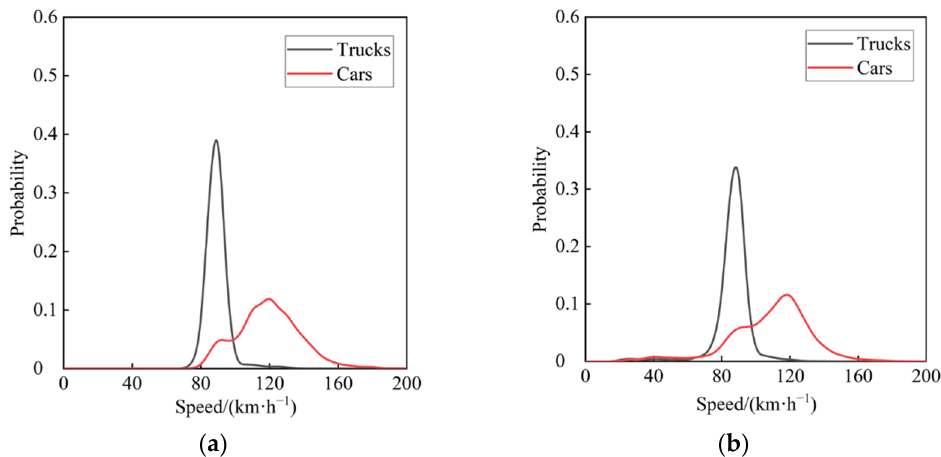
Figure 3. ( a ) Speed distribution on four-lane divided freeways; ( b ) speed distribution on six-lane divided freeways.